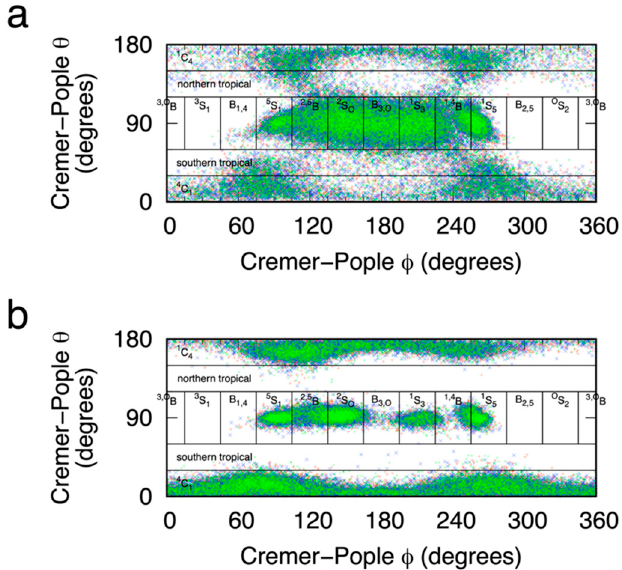
Figure 6. Me α IdoA Cremer-Pople ( θ , φ ) values sampled during eABF ( a ) and CMAP-biased ( b ) molecular dynamics simulations. Pyranose ring puckering regions [56] (“ 4 C 1 ”, “northern tropical”, “ 2 S O ”, etc.) are labeled as defined in the Materials and Methods section. Biasing was applied to the Babin-Sagui ( α 1 , α 2 ) reaction coordinate. Data in each panel are from triplicate simulations (blue, red, and green) seeded with different random initial velocities. eABF simulations were 200 ns and CMAP-biased simulations were 1000 ns.